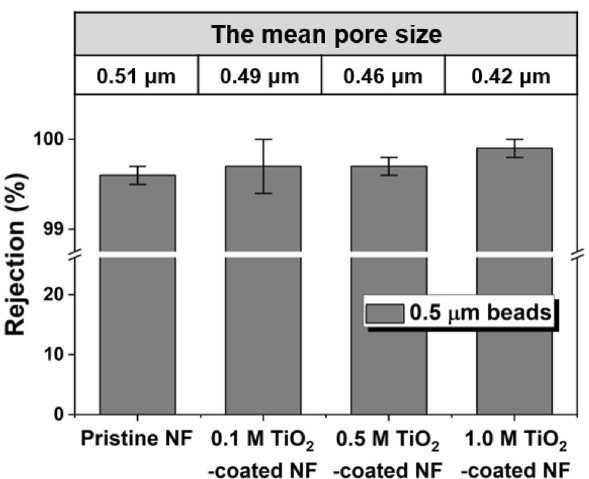
Figure 6. The rejection rate (%) of YSZ/silica (pristine) and TiO 2 -coated YSZ/silica NF with 0.5 μm polymeric